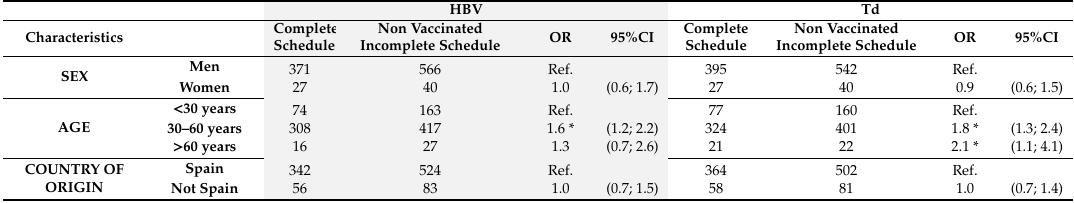
Table 4. Statistical associations for HBV and Td (odds ratio (OR)). HBV Td